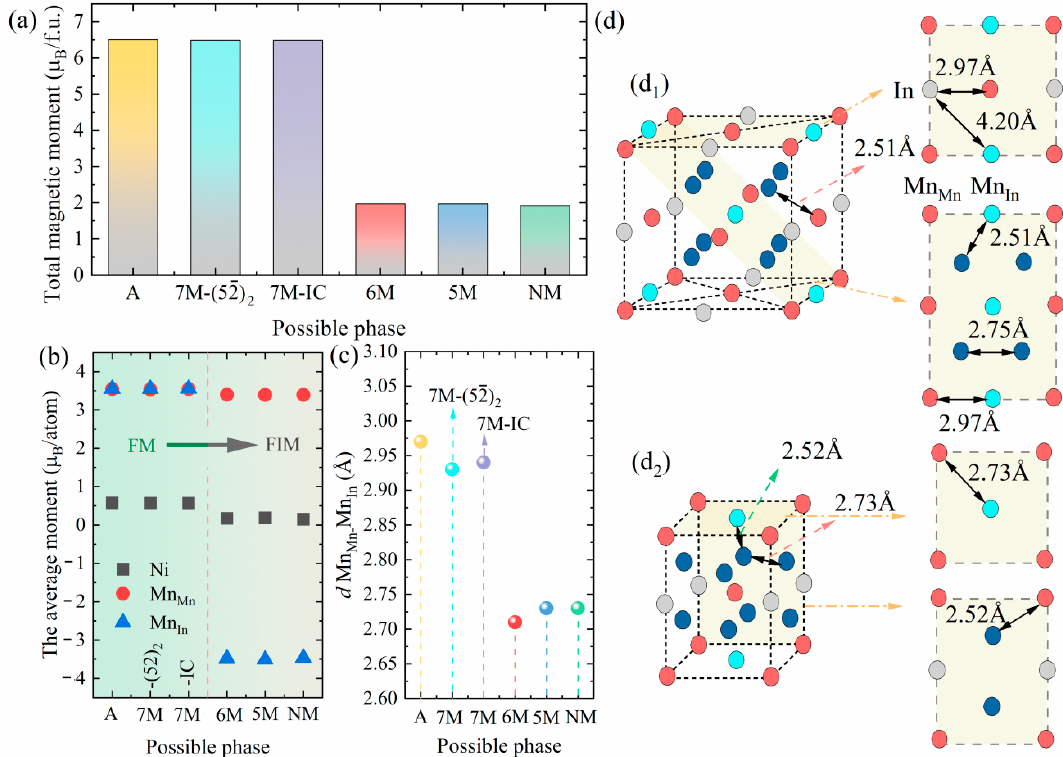
Figure 4. ( a ) Total magnetic moment, ( b ) average of Ni, Mn Mn , and Mn In moments, ( c ) nearest-neigh- bor atomic distance between Mn Mn and Mn In atoms of Ni 2 Mn 1.5 In 0.5 alloy, and ( d ) schematic diagram of the nearest atomic distance for ( d 1 ) A phase and ( d 2 ) NM phase.